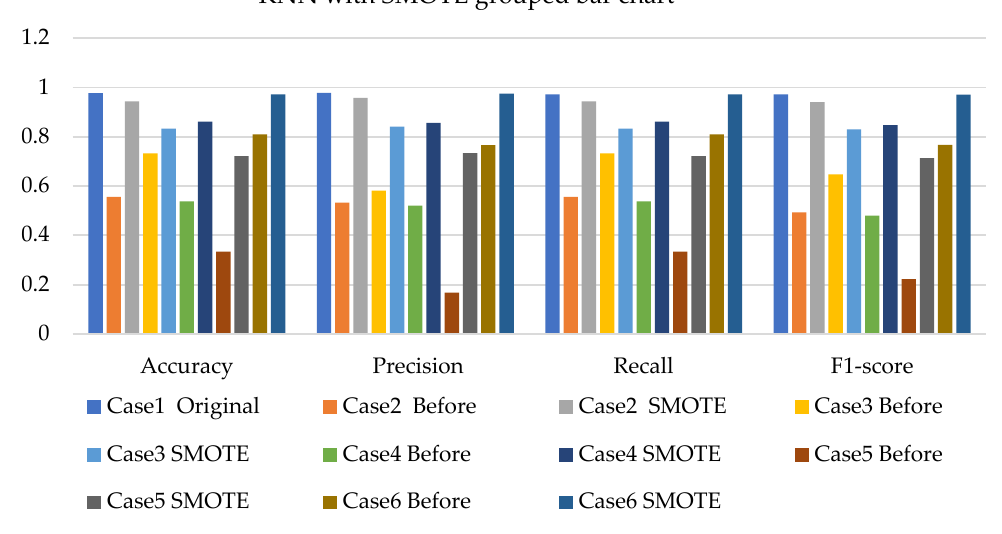
Figure 20. Experimental performance of k-NN classification with SMOTE.